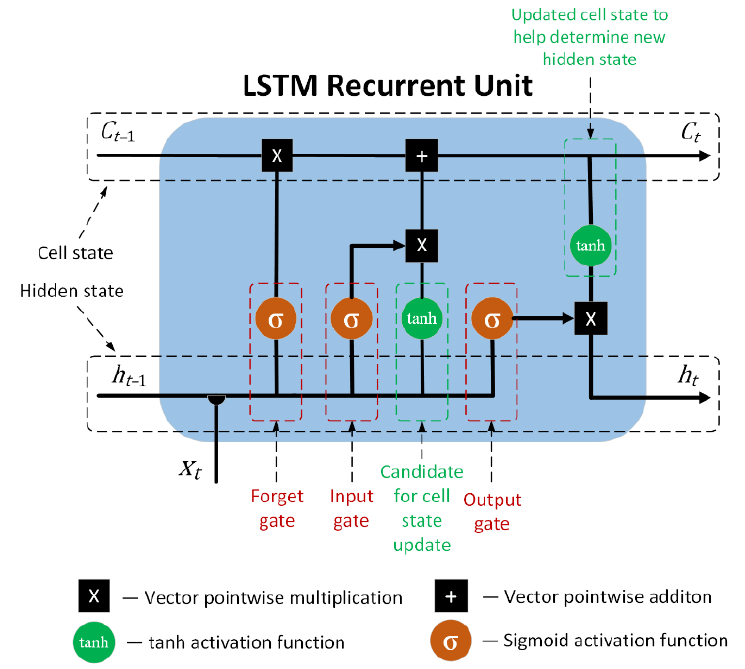
Figure 3. LSTM-RNN network block diagram.